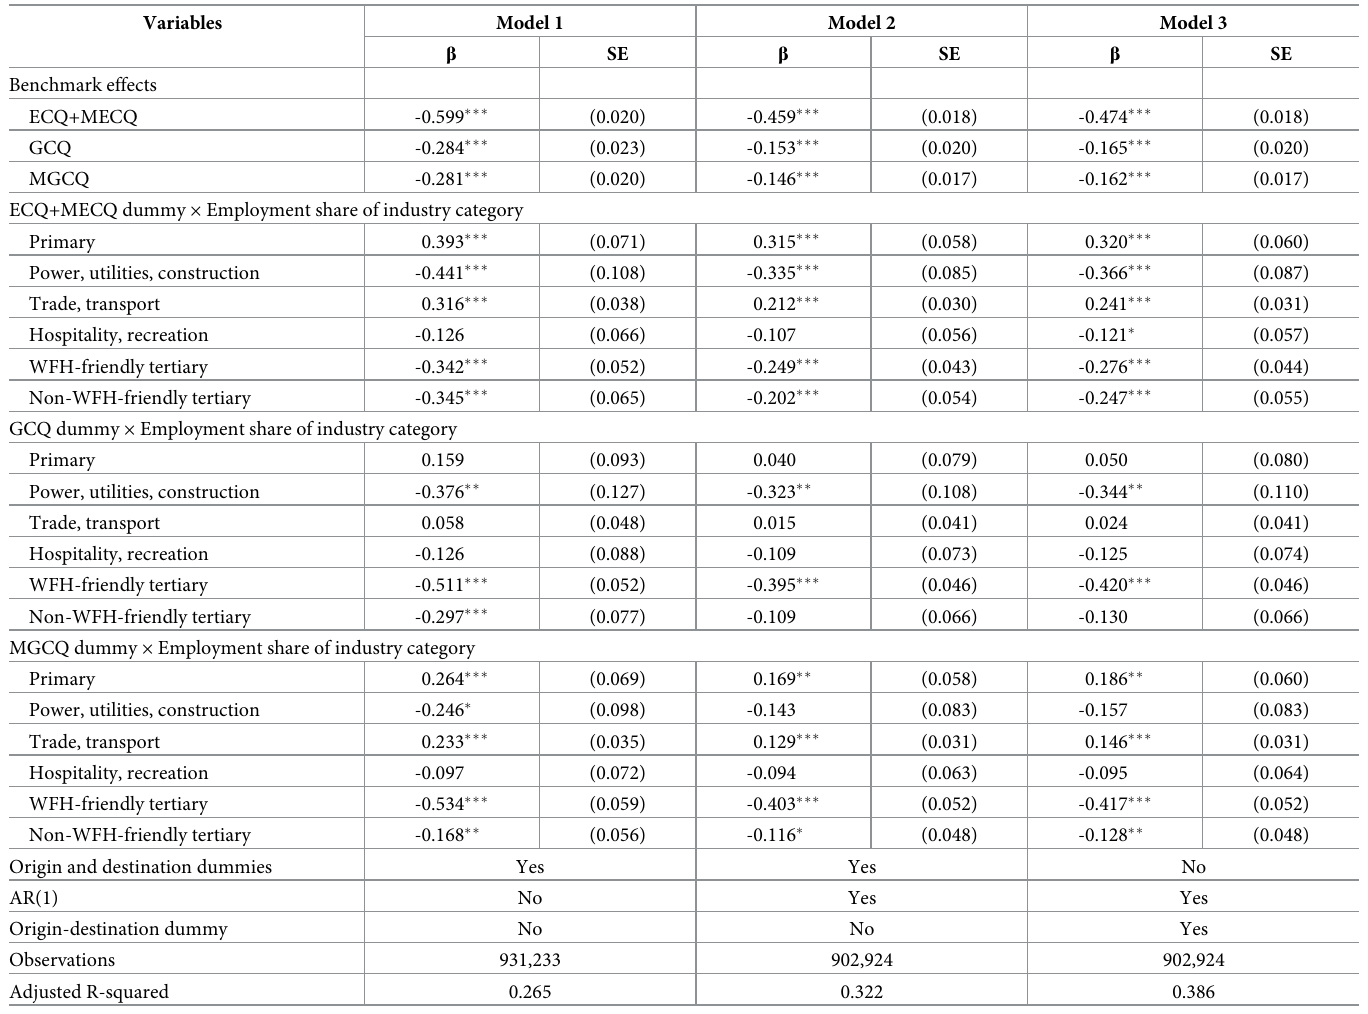
Table 2A. Effects of lockdown measures by destination city industrial composition